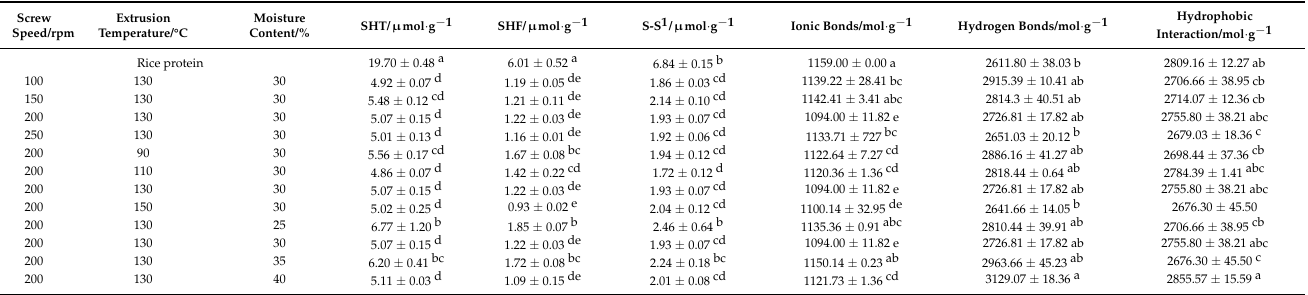
Table 5. Structural properties of TRP with different extrusion